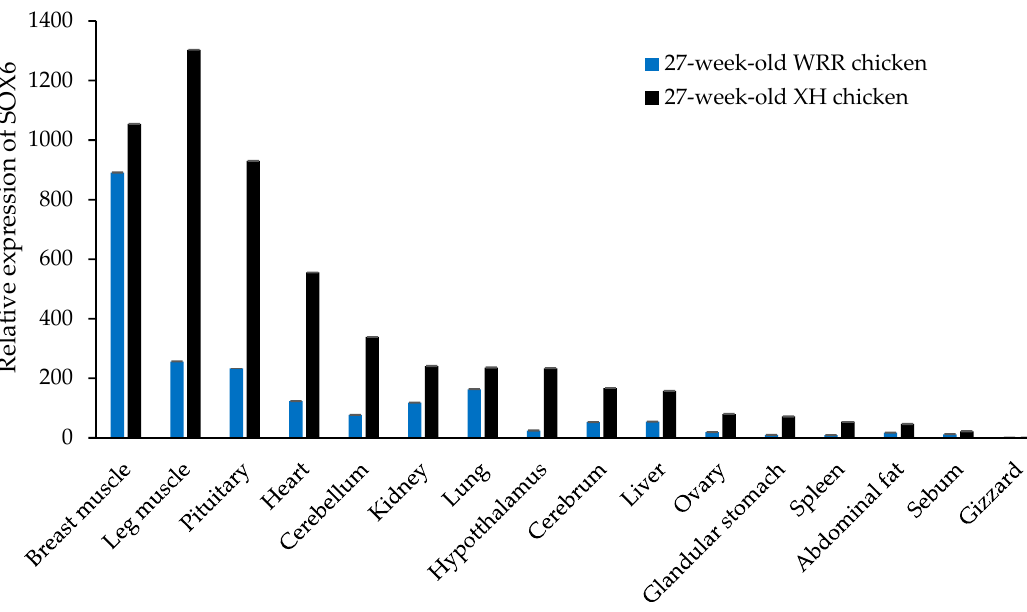
Figure 5. The tissue expression pattern of SOX6 in both 27-week-old XH and WRR chickens. Additionally, the expression level of SOX6 in the breast muscle of variant XH chickens with CN = 3 was about two times higher than that of the normal individuals (CN = 2), and that in the leg muscle,